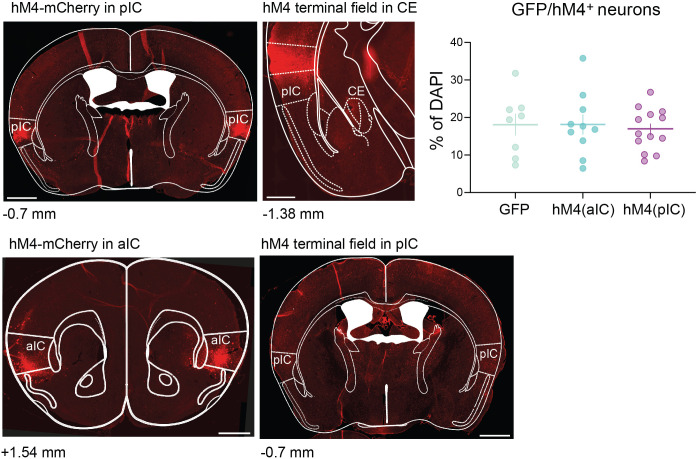
Histological verification of the chemogenetic pIC–CE and aIC–pIC manipulation cohorts.(left) Exemplary pIC and aIC AAV-DIO-hM4-mCherry injection site and (middle) terminal hM4-mCherry field in CE and pIC; scalebar = 900 (full sections) and 100 µm (zoom-in). (right) Quantification of GFP and hM4 infection rate in aIC and pIC presented as percent of GFP/hM4 positive neurons over DAPI (data shown as mean ± SEM).